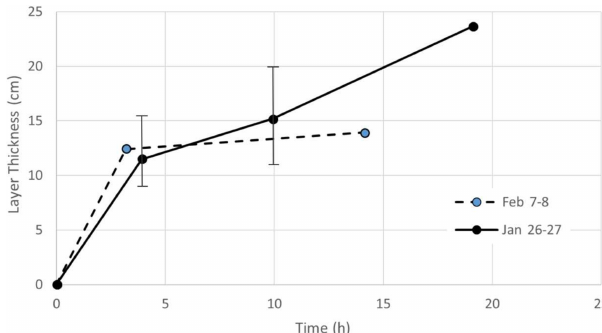
Figure 6. Estimates of anchor ice accretion above the elevated SWIPS transducers during the 26–27 January and 7–8 February blockage events as a function of time since event onset. The 26– 27 January error bar data are representative of both